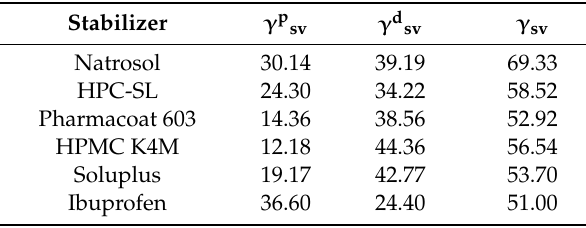
Table 2. Polar, γ p sv , and dispersion, γ d sv , components, together with the total surface free energy, γ sv , (in mN / m) of stabilizers determined by the contact angle